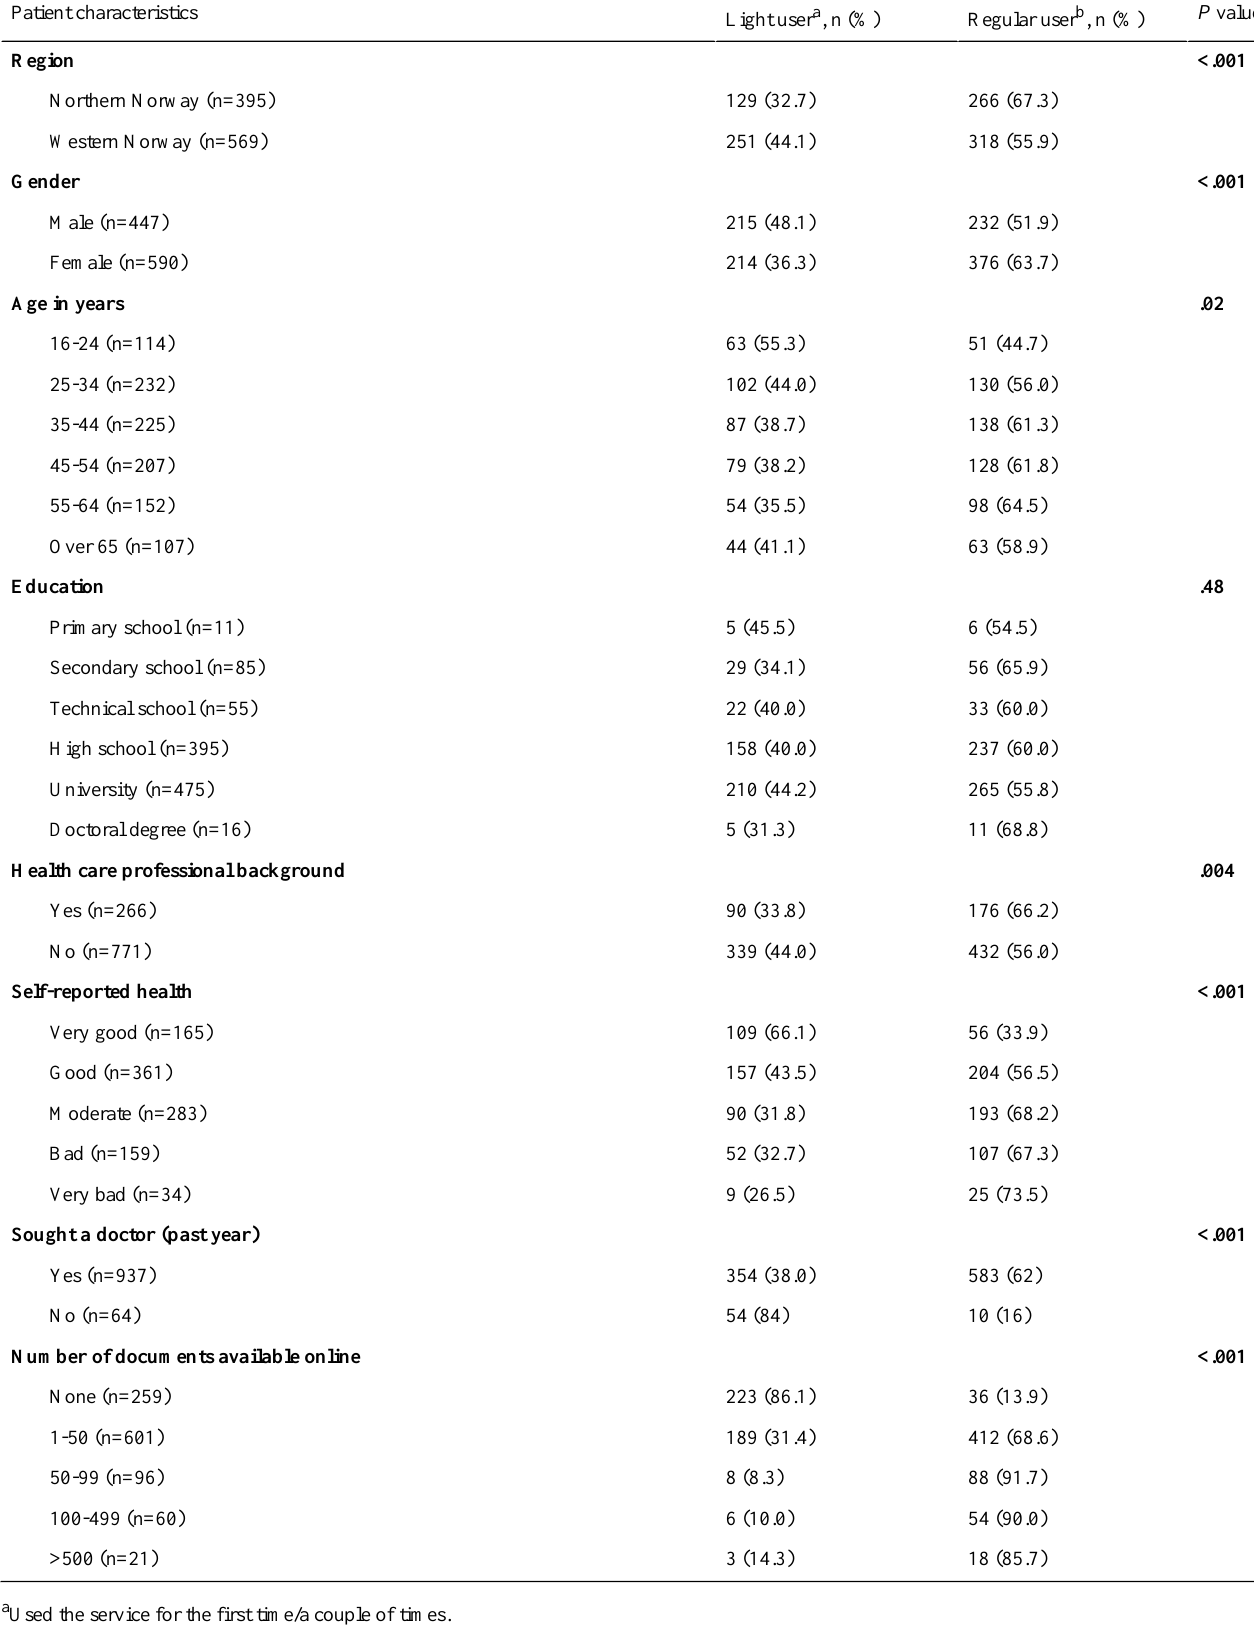
Table 3. Association between service utilization and patient